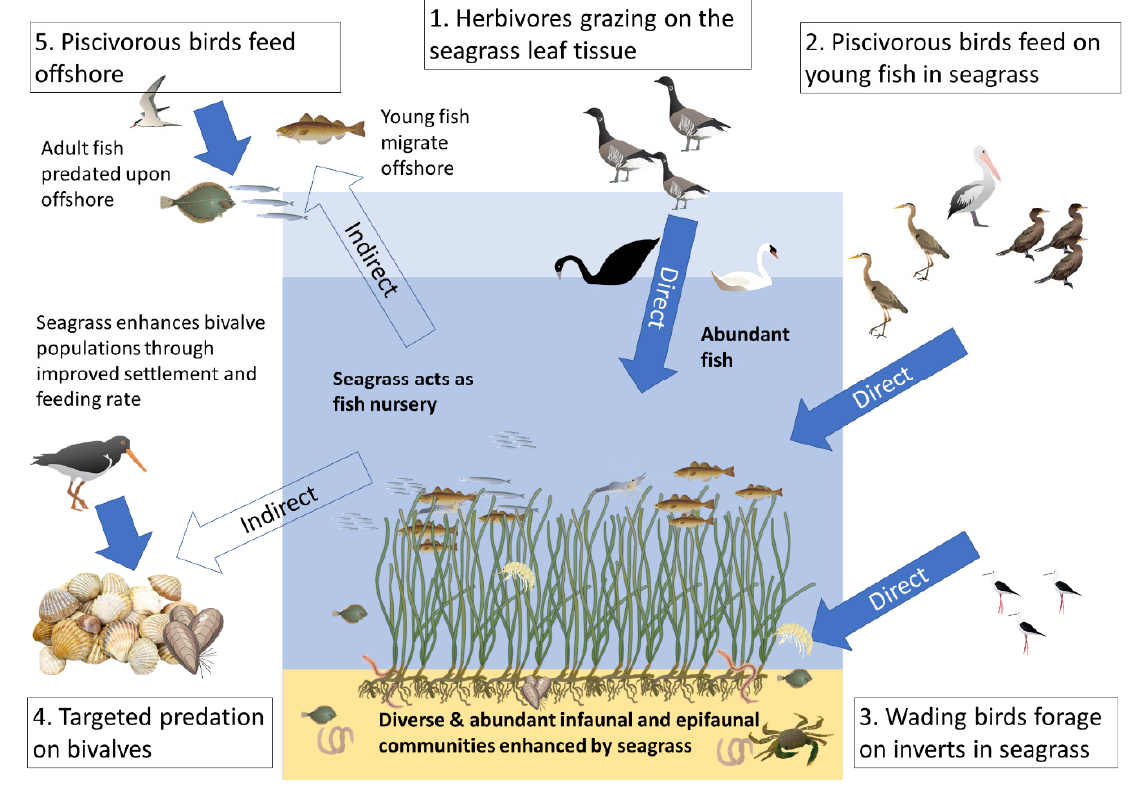
Figure 1. Conceptual diagram examining the potential links between seagrass and seabirds in NE Atlantic coastal seas. These hypothesised links are split between direct consumption of seagrass ( 1 ) or seagrass-associated fauna ( 2 and 3 ) and those indirect links from consumption of populations benefitting from seagrass ( 4 and 5 ).